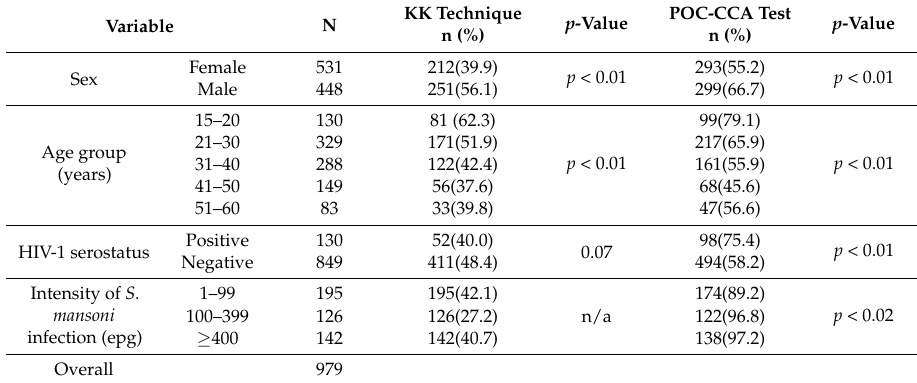
Table 2. Prevalence of S.mansoni infection based on Kato Katz technique and point-of-care circulating cathodic antigen test, stratified by sex, age and HIV-1 infection